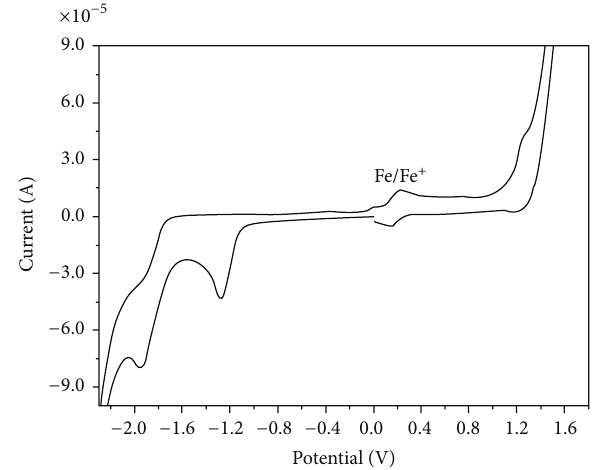
Figure 7: The cyclic voltammogram of 1 measured in dichloromethane solution with ferrocenium/ferrocene, at 200